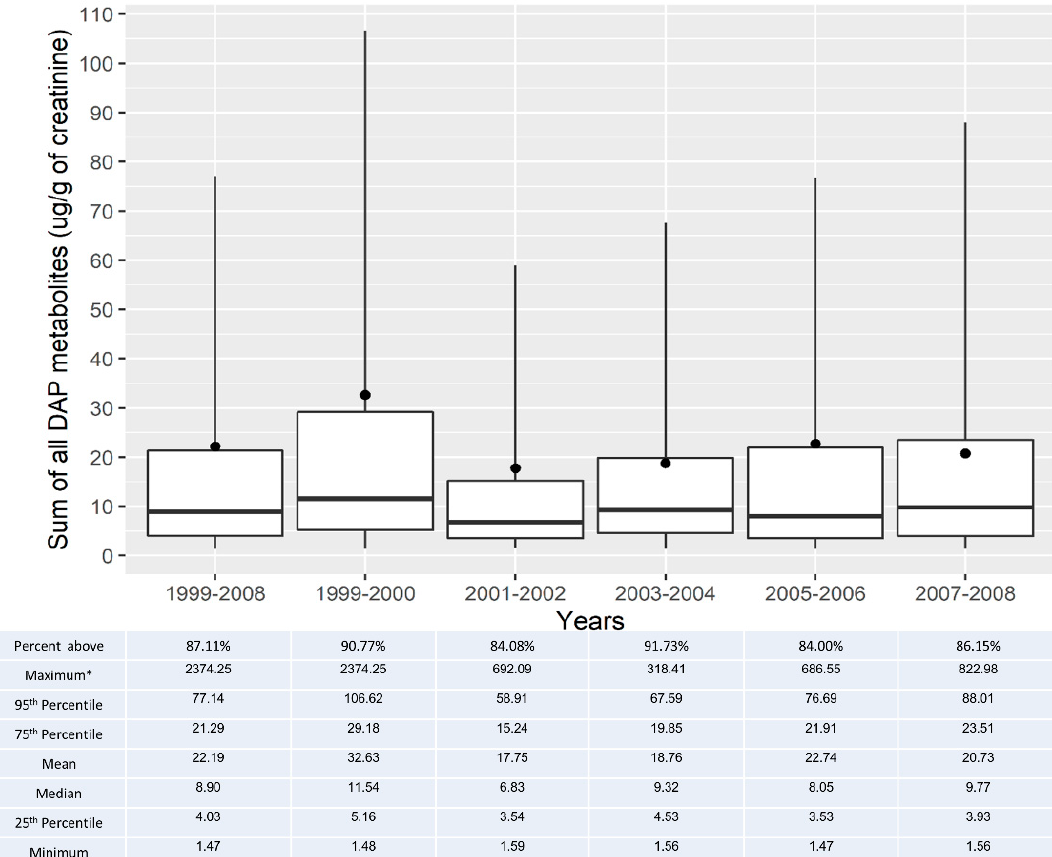
Figure 1. Time trends in the sum of all urinary DAP metabolites in adults from 1999 to 2008 with at least one DAP metabolite at or above the DL. Notes: Boxplots represent the minimum, first quartile, median, third quartile, and 95th percentile values. Mean values are represented by the black circle. * Indicates value not depicted in the figure.